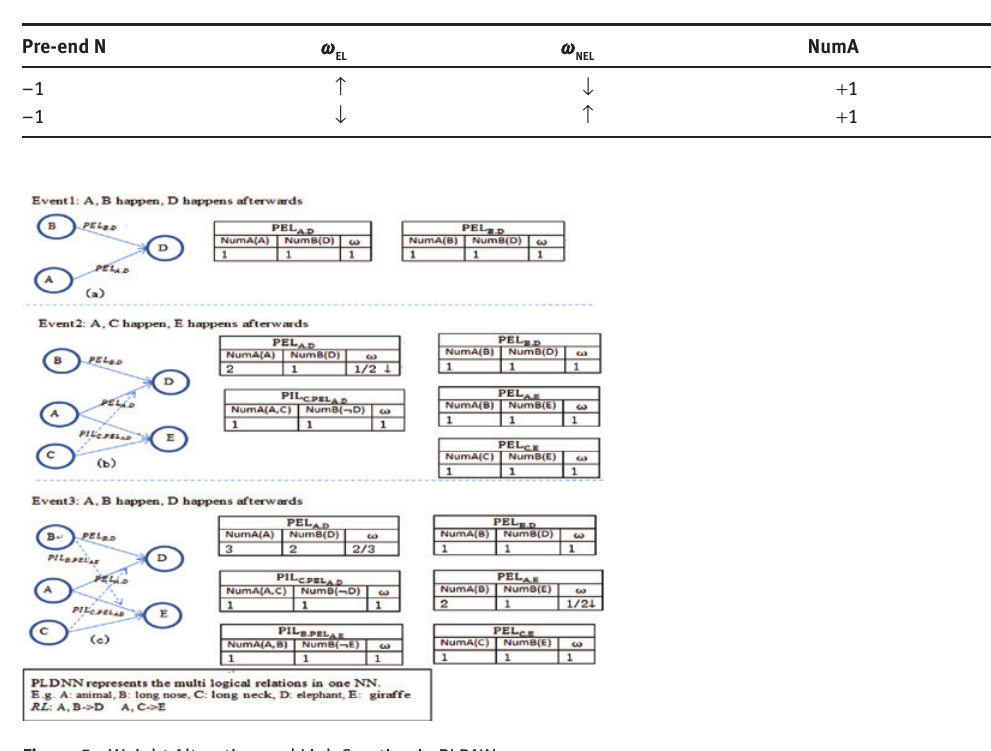
Figure 5: Weight Alteration and Link Creation in